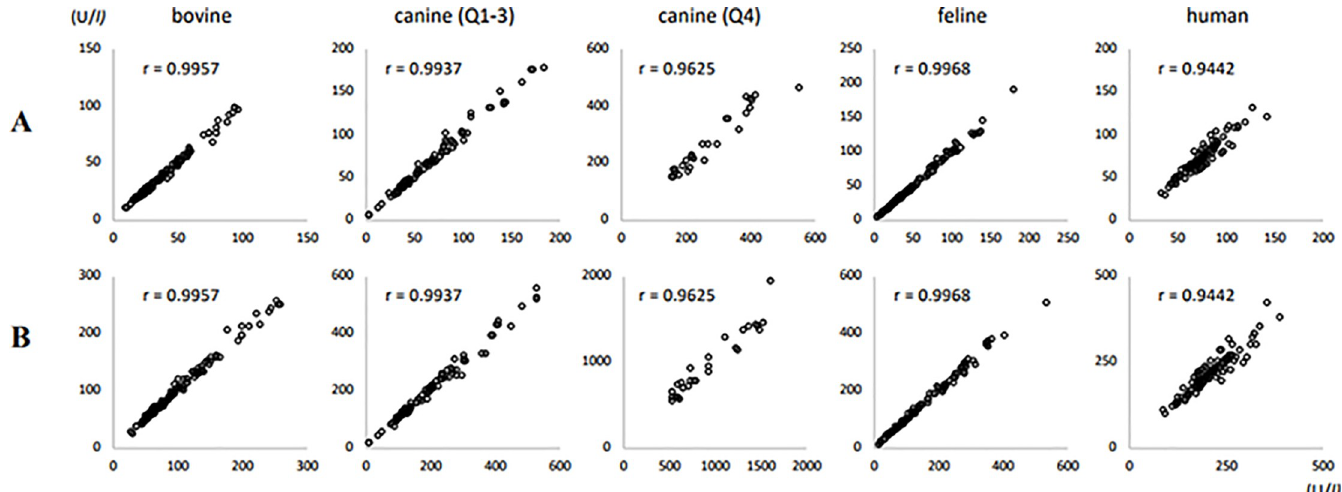
Fig 3. Scatter plots of the measured values (x-axis) and estimated values (y-axis) using the conversion factors. A: Measured IFCC values (x) and estimated IFCC values (y) obtained from the JSCC values using the conversion factors. B: Measured JSCC values (x) and estimated JSCC values (y) obtained from the IFCC values using the conversion